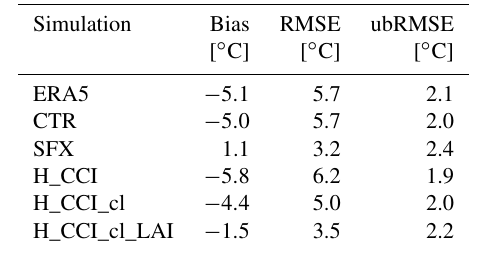
Table 2. Bias, RMSE, and ubRMSE (unbiased RMSE) computed from JJA daily maximum LST bias average over entire Iberia, for each model-based dataset considered in the present study, using LSA-SAF LST as